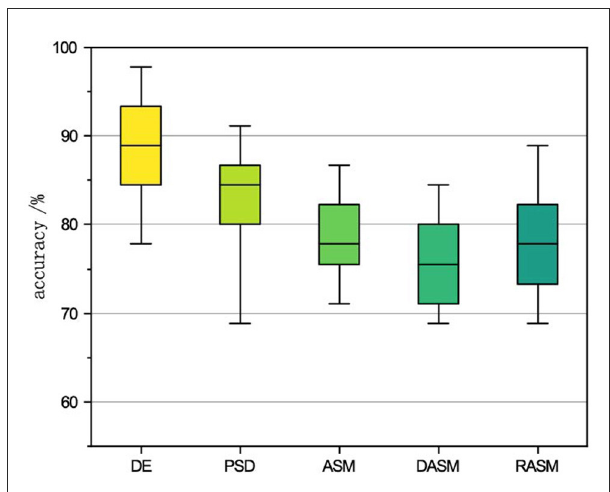
FIGURE2 The impact of different features on SEED accuracy.